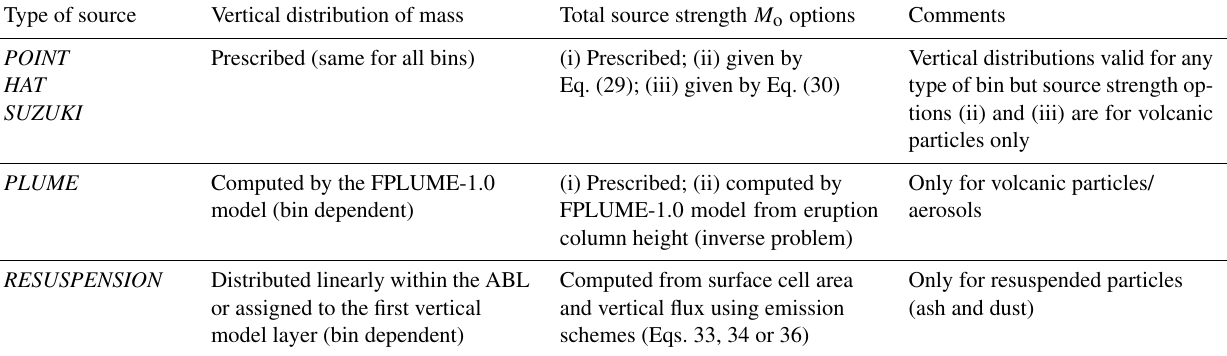
Table 5. Options available in FALL3D-8.0 for vertical distribution of mass and total source strength depending on the type of emission source S e